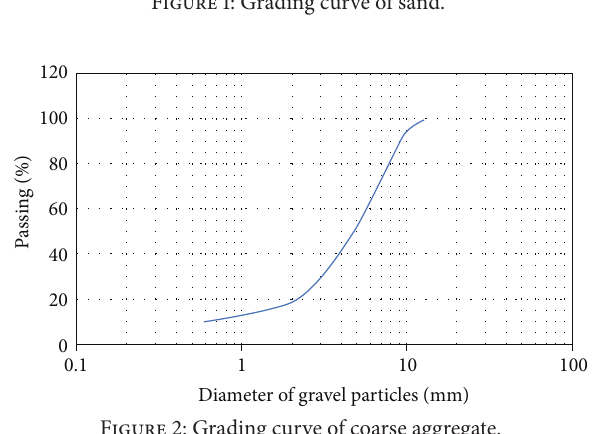
Figure 2: Grading curve of coarse aggregate. Table 2: Some properties of acrylic polymer.